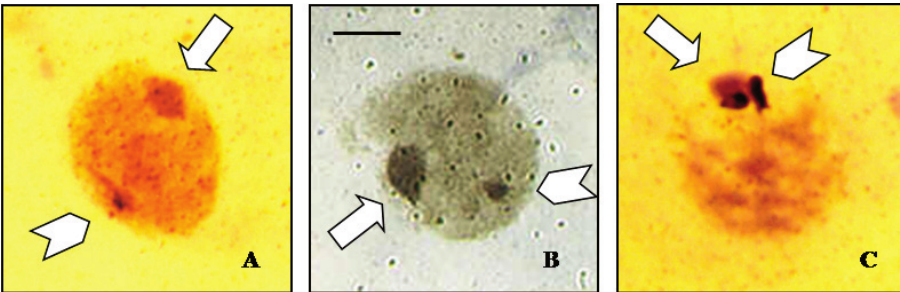
Figure 4a–c. Silver staining of meiotic nuclei, showing nucleolar activity on the autosomes of a C. hispanica , and b C. circumdata , and on the sex chromosomes of c C. trisignata . Arrows indicate the sex chromatin and arrowheads point the nucleolar active sites. Bar = 5